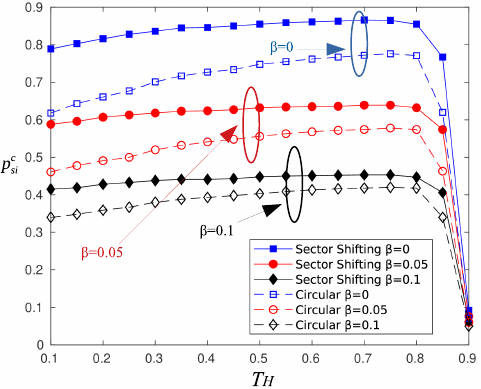
Figure 18. Probability of successful information reception using the sector shifting